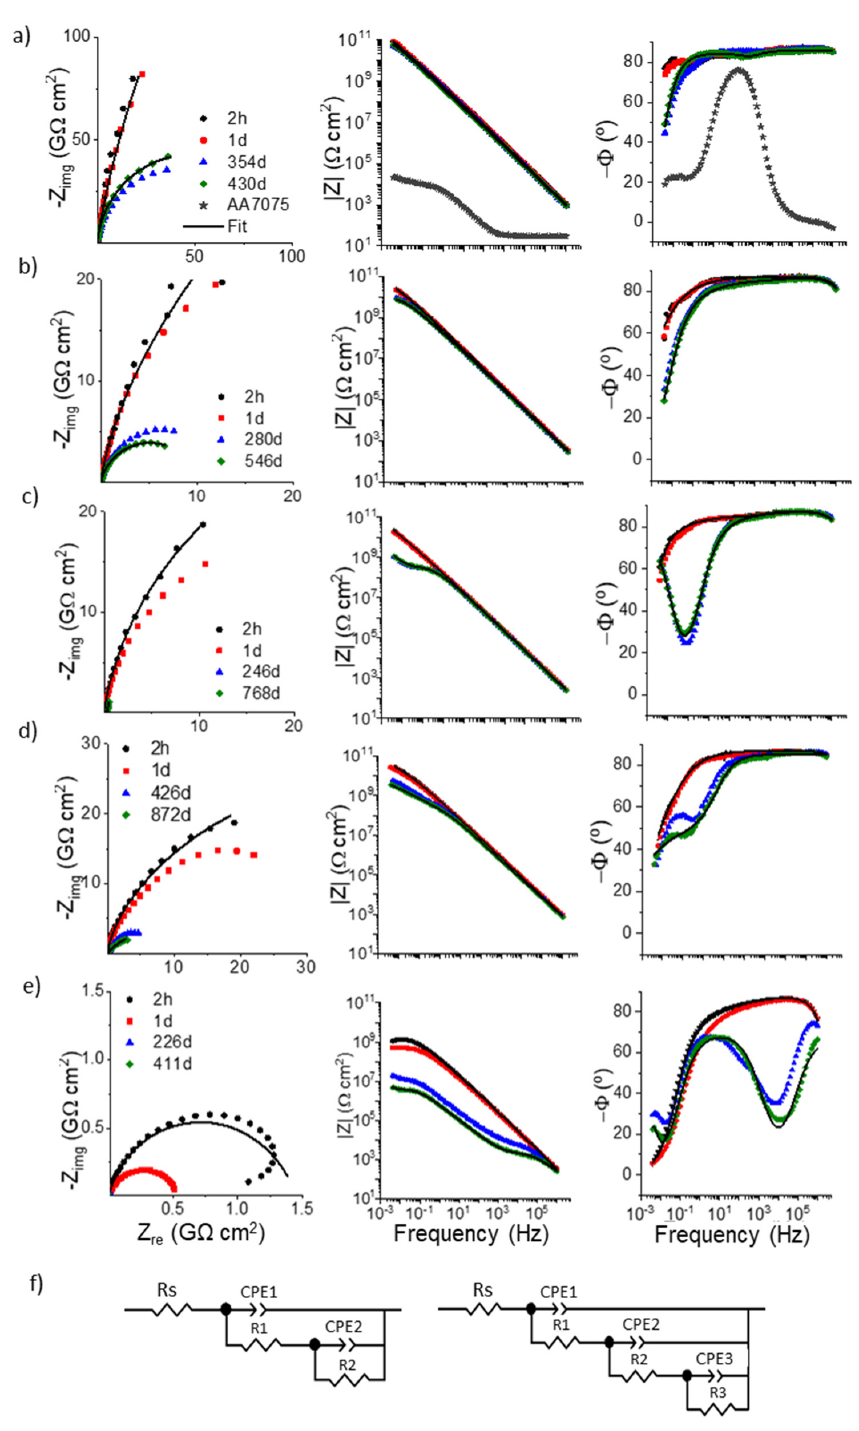
Figure 7. Time dependence of Nyquist and Bode plots for PMMA–silica coatings with increasing lithium addition; ( a ) Li0 (0 ppm), ( b ) Li05 (500 ppm), ( c ) Li1 (1000 ppm), ( d ) Li2 (2000 ppm), and ( e ) Li4 (4000 ppm); ( f ) electrical equivalent circuits used to fit the EIS data (black lines). The EIS data of the first and last measurements were fitted using electrical equivalent circuits (EEC) presented in Figure 7f. They are composed of a solution resistance (R s ) in series with RC elements related to two (Li0–Li2) and three (Li4) time constants. Generally,